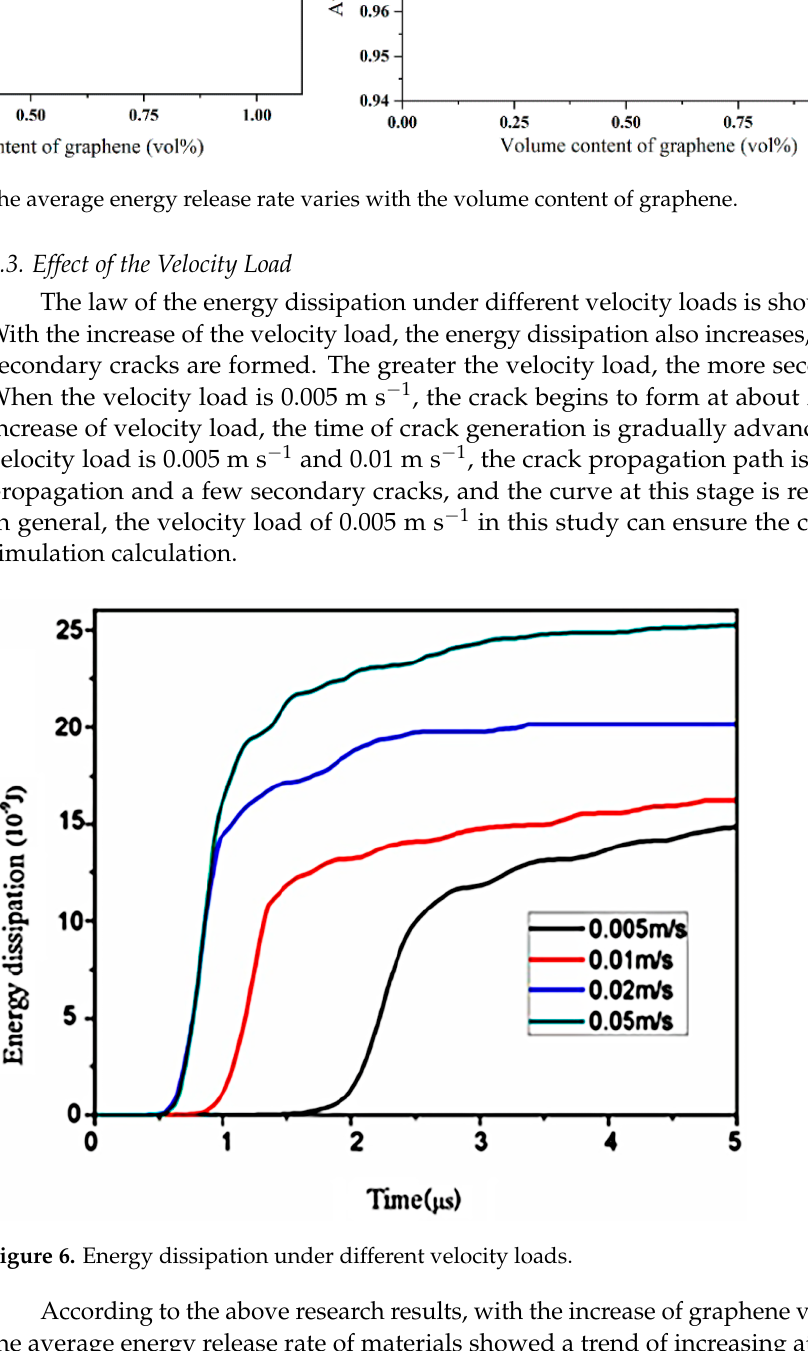
Figure 6. Energy dissipation under different velocity loads. According to the above research results, with the increase of graphene volume content, the average energy release rate of materials showed a trend of increasing at first and then decreasing. When the volume content of graphene is 0.50 vol.%, the average energy